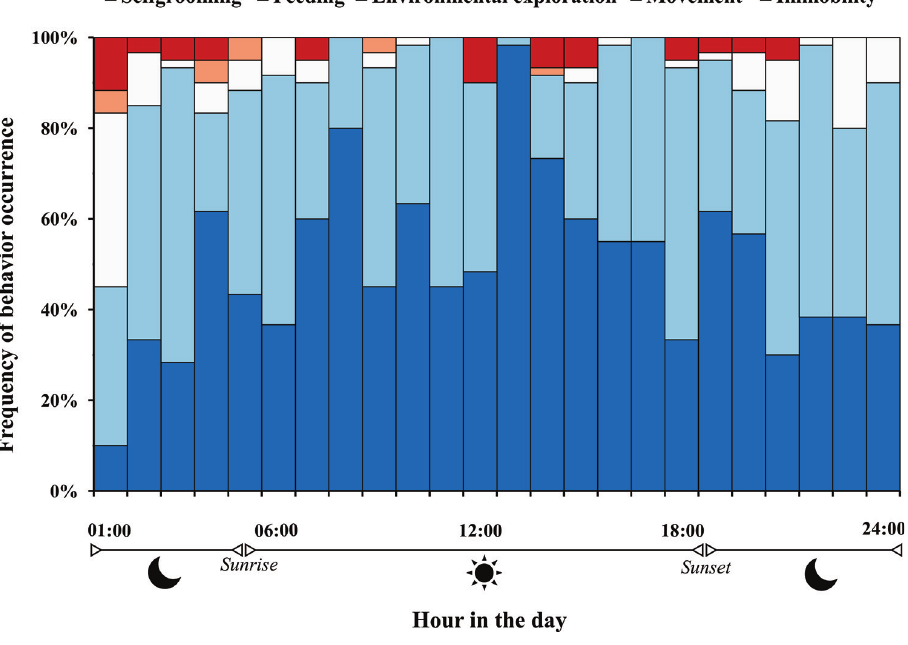
Figure 5. Behavioral category frequency for all Charinus ruschii sp. n. individuals in 1440 minutes of observa- tion. Sun icon represents the diurnal period and moon icon the dark